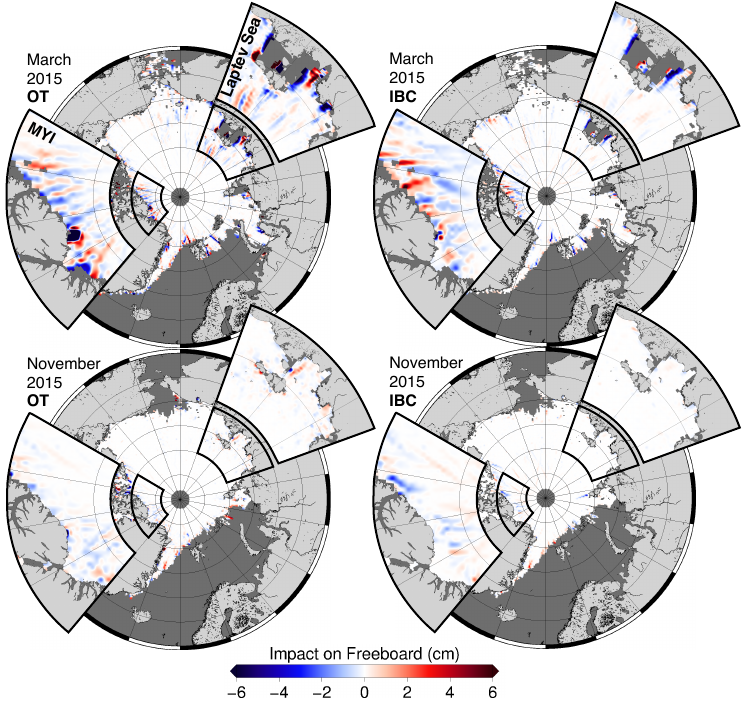
Figure 4. The maps show the impact of the ocean tides (OT) and inverse barometric correction (IBC) on the CryoSat-2 freeboard regarding the monthly mean freeboard for March and November 2015, averaged on a 25 × 25 km EASE2 grid. Major impact spots are the multiyear ice (MYI) north of Canada, fast ice zones (e.g., Laptev Sea) and the ice edges.